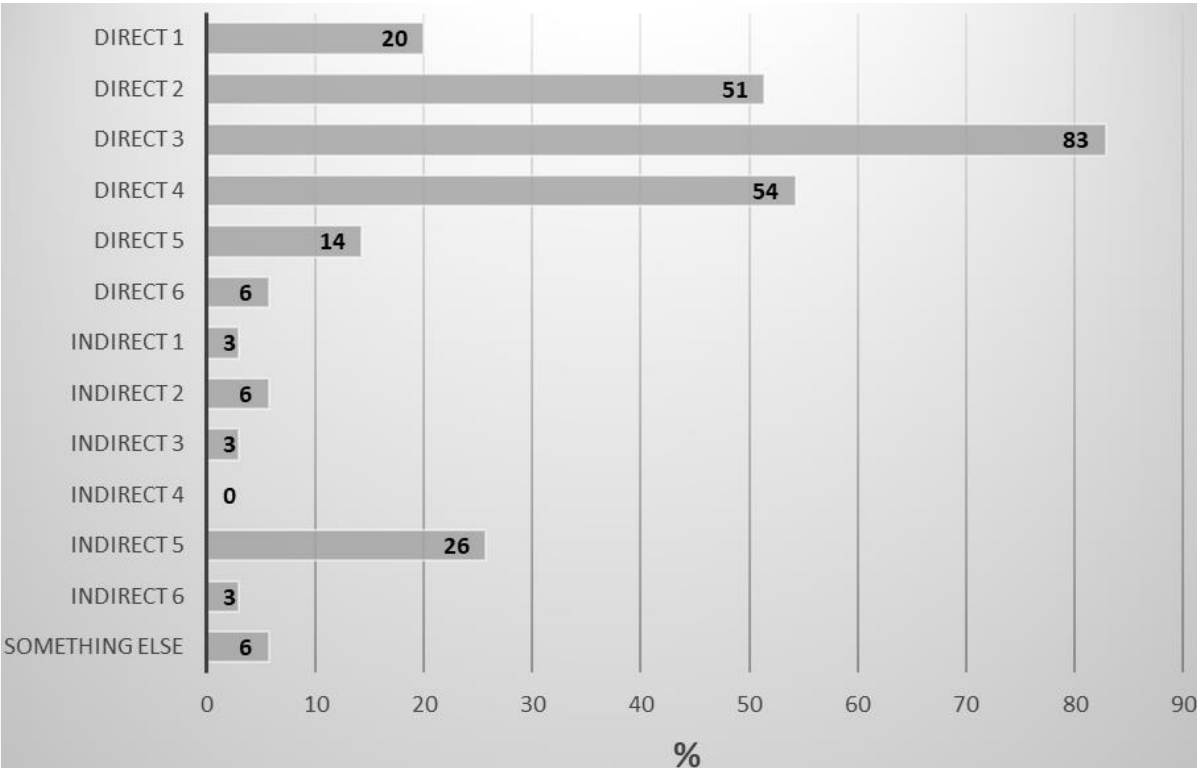
Figure 1. The best ways to support the Just Transition process according to Finnish peat entrepreneurs (n = 35, the number of selected choices = 96). For explanation of the 12 choices, see Table